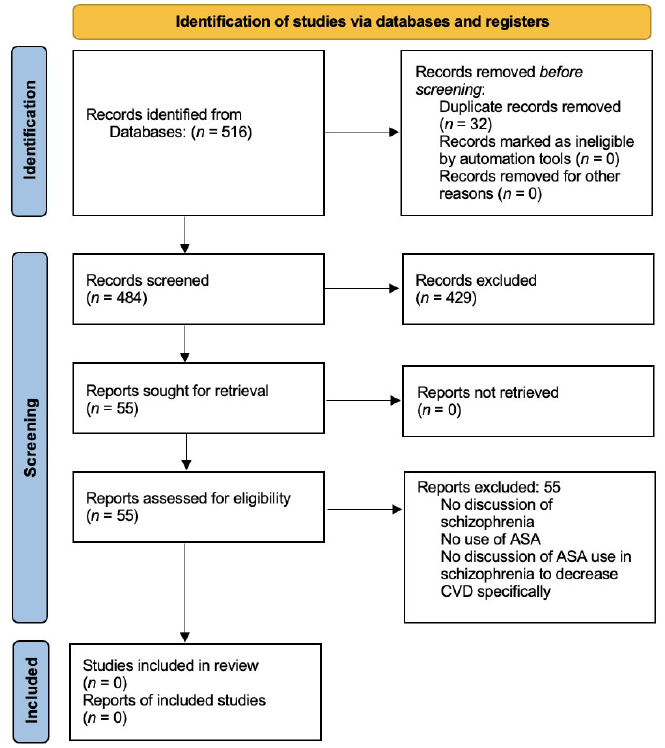
Figure 1. PRISMA 2020 flow diagram for our systematic review including searches of databases and registers.